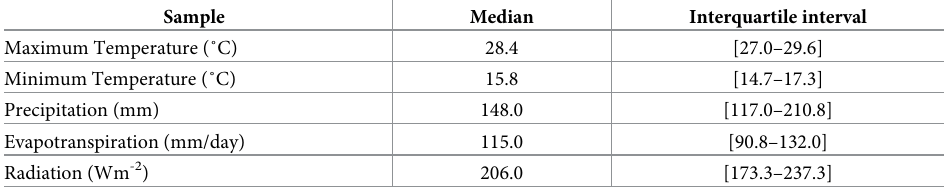
Table 2. Median and interquartile interval of abiotic variables extracted from georeferenced points of occurrence/ accident cases of Lonomia spp. in Misiones,